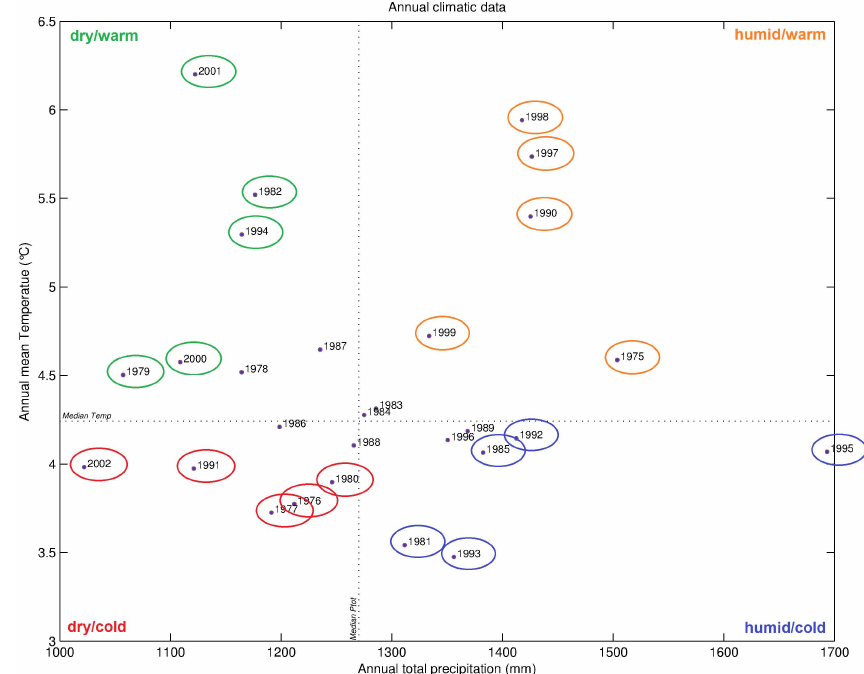
Fig. 4. Time series clustering results for the Au Saumon catchment